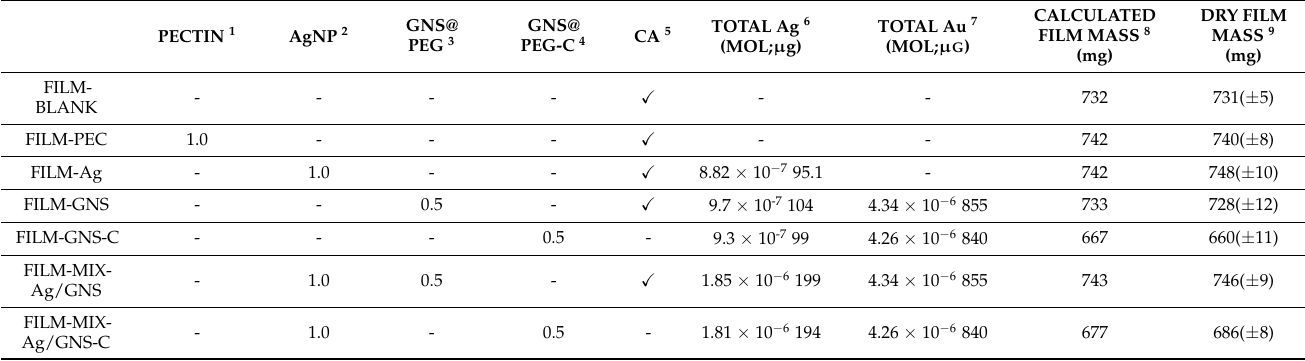
Table 1. Composition of the film-forming